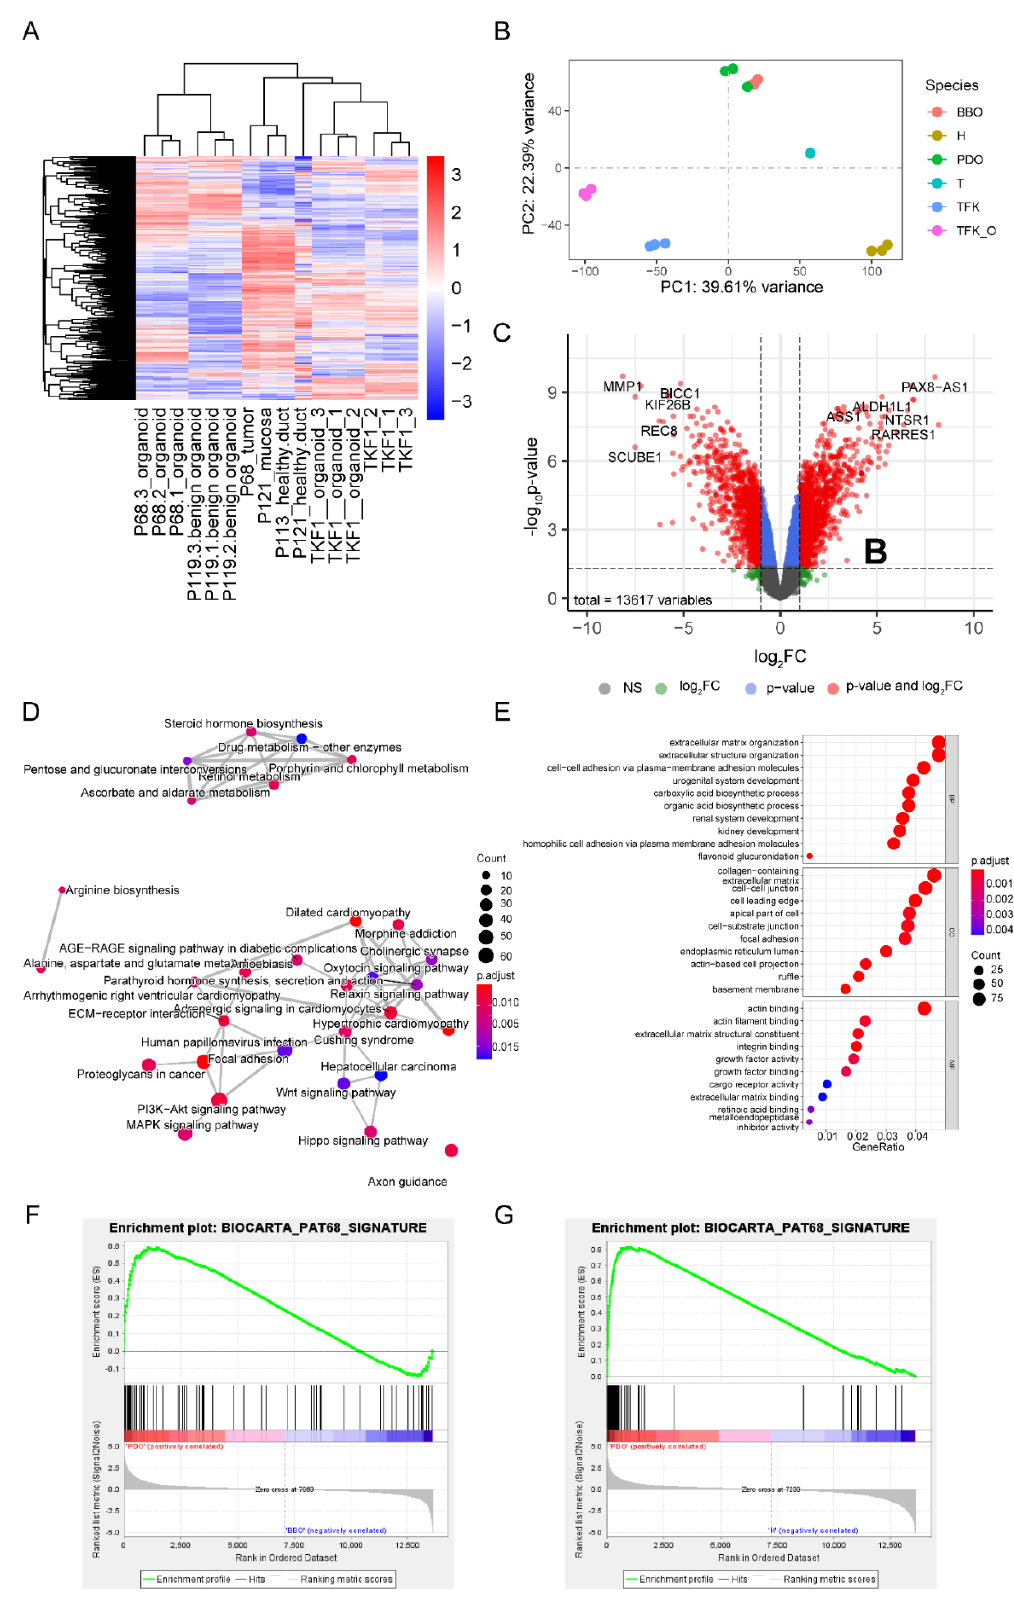
Figure 5. Patient-derived organoids recapitulate features of the primary tumor. ( A ) Heatmap of 2770 significantly regulated genes among all RNA sequencing samples; ( B ) Principal component analysis (PCA) of sequencing samples, each dot represents one sample, x-axis, principal component 1, represents 39.61% variance; y-axis, principal component 2, represents 22.39% variance; ( C ) The volcano plot reflects the existing significantly different expression features between patient- derived organoids and benign biliary organoids. There were 13,617 variable features in total; both p -value and fold change